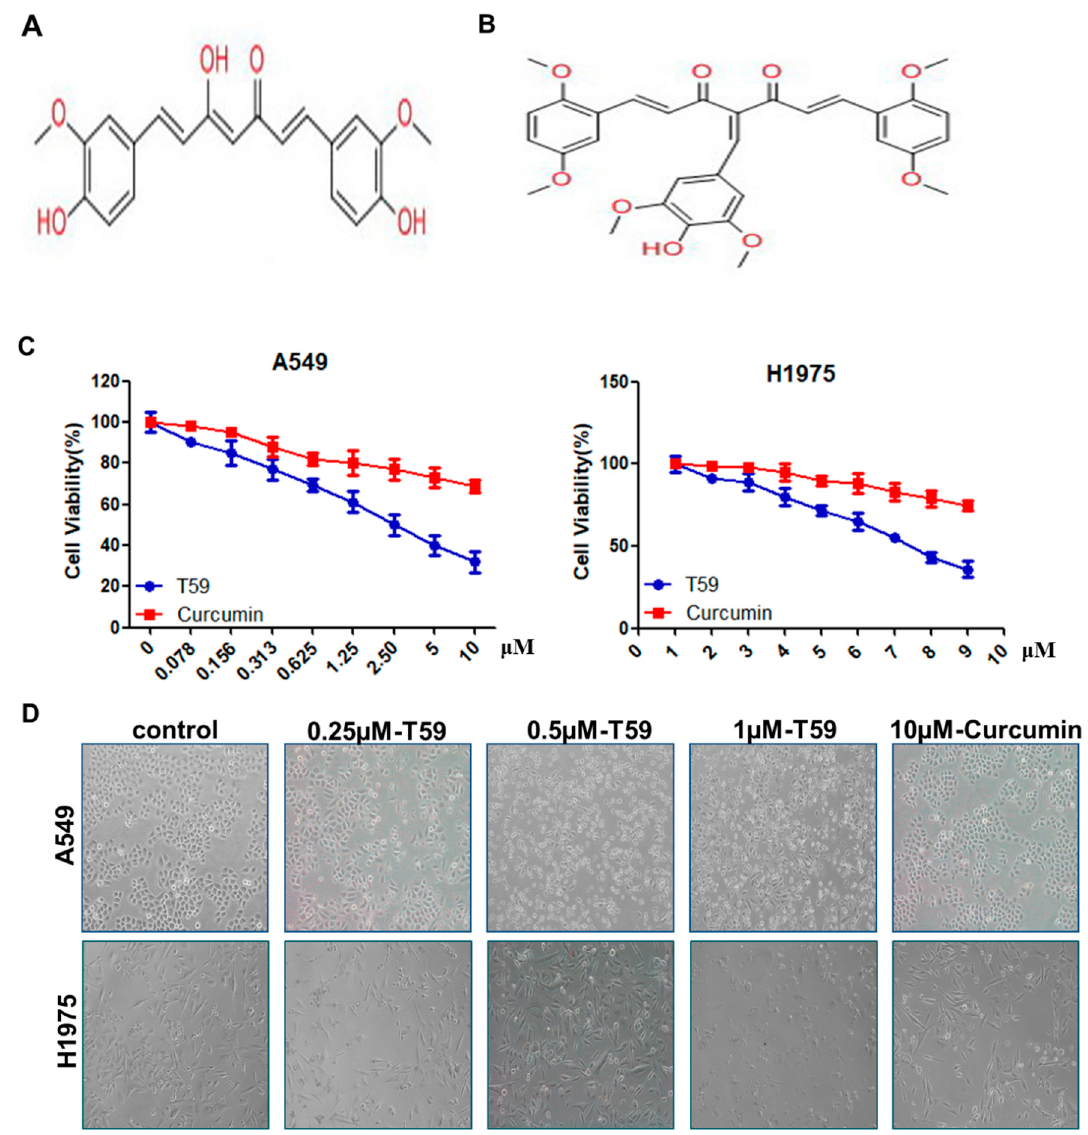
Figure 1. Structure of T59 and the cytotoxicity of T59. ( A ) Structure of curcumin [C 21 H 20 O 6 , 1,7-bis-(4-hydroxy-3-methoxyphenyl)-hepta-1,6-diene-3,5-dione]. ( B ) Structure of curcumin derivative T59 [C 32 H 32 O 9 ]. ( C ) Cytotoxicity of T59 and curcumin on human lung cancer cells A549 and H1975 were measured by MTT assay at 24 h. ( D ) Representative images (×100) of cellular morphology after treated with 0.250, 0.500, and 1.00 μ M T59 and with 10.000 μ M curcumin for 24 h.